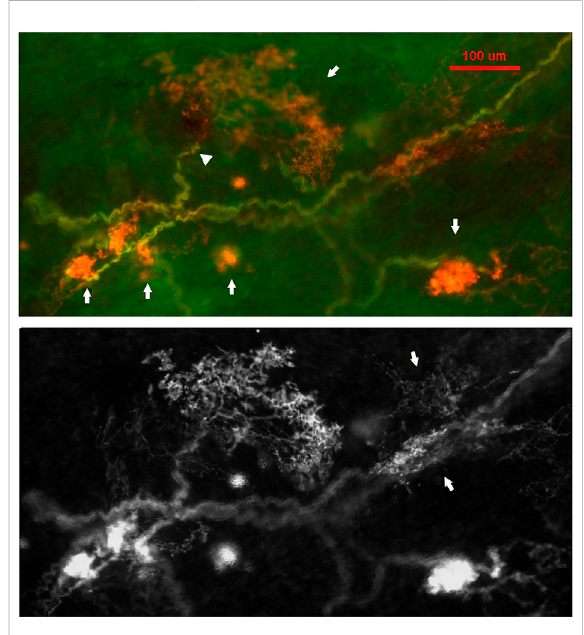
FIGURE 9 A double staining approach (Na + /K + -ATPase and MBP) identi fi es two types of BR CUEs: compact type (solid and ball-like structures denoted by four arrows in upper fi gure); diffuse type (much larger, extended structure denoted by an arrow in the upper middle of the fi gure). The intensity of the staining is much higher in the former. Both types share the same myelinated afferent (green axons). An arrowhead denotes the diffuse type, which is much more observable in the bottom black and white fi gure, where two arrows denote two other smaller diffuse CUEs. The scale bar is 100 μ m [Figure 3 (Liu et al.,